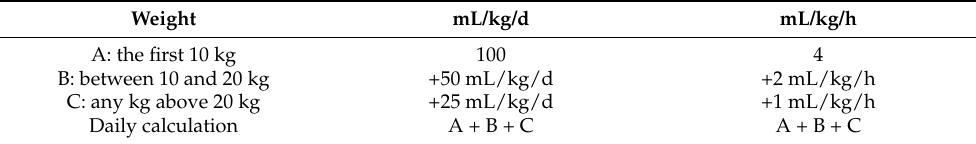
Table 3. Holiday and Segar formula for maintenance fluid calculation. Weight mL/kg/d